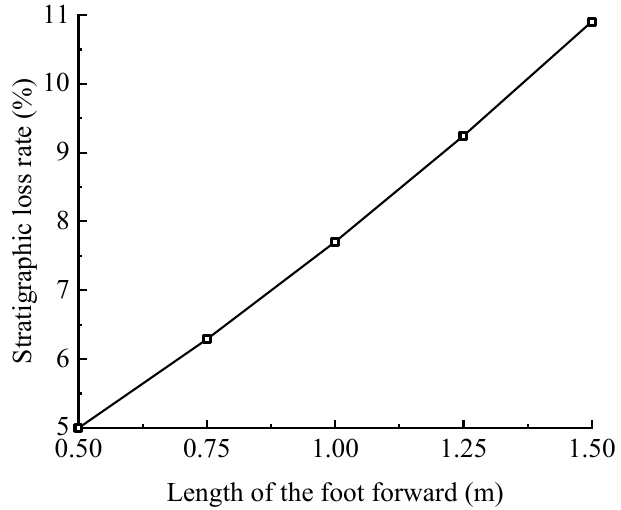
Figure 13. Relation curve between the excavation footage length and formation loss rate.